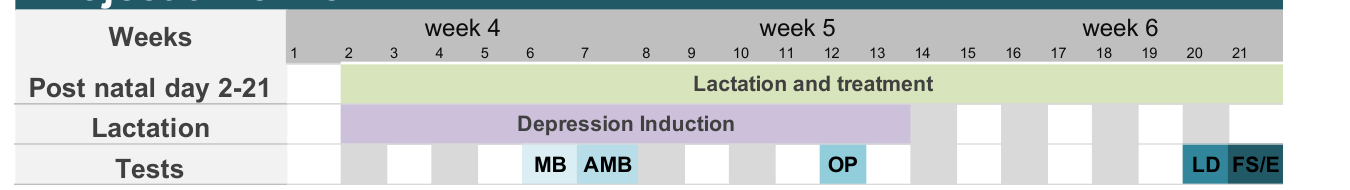
Figure 1. Timeline of experimental procedures. MB: maternal behavior; AMB: aggressive maternal behavior; OP: olfactory preference; LD: light/dark box; FS/E: forced swim test and euthanasia.